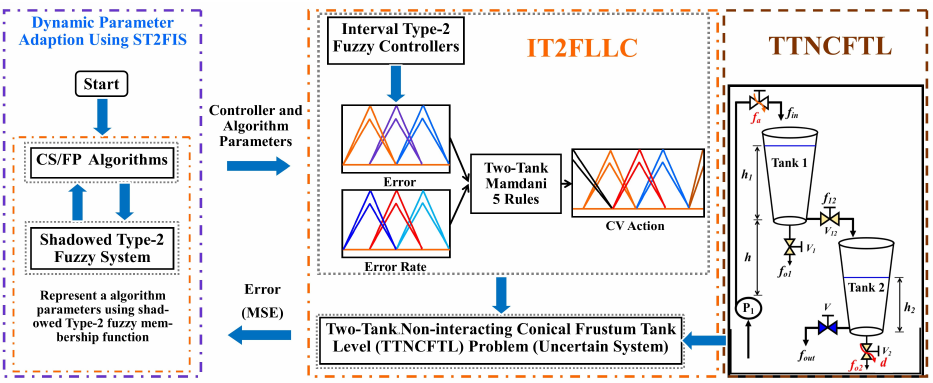
Figure 6. Proposed optimization method using metaheuristic